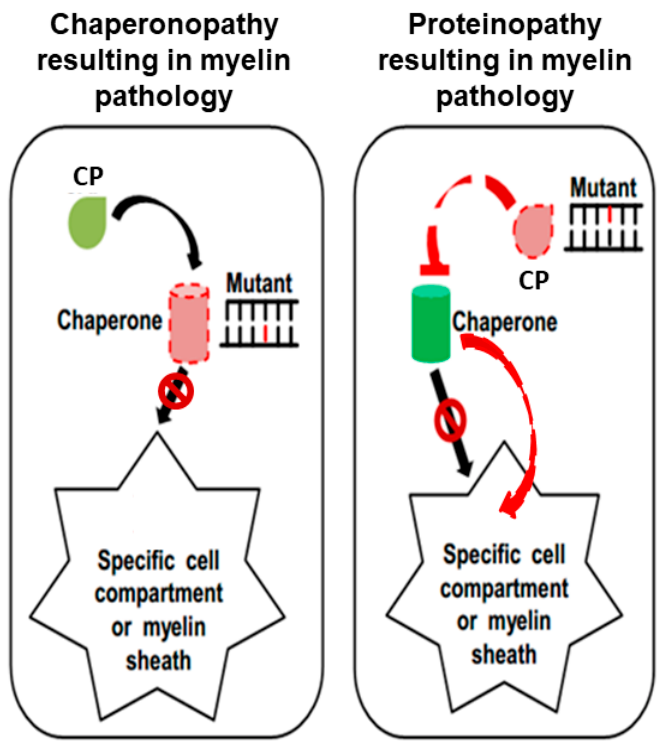
Figure 1. Hypothetical mechanisms involving chaperones in myelination and myelin pathology. Molecular chaperones (normal: green cylinder; abnormal: pink cylinder with dashed-red borders) assist the folding of myelin proteins (drop-shaped icons; normal, light green; abnormal, pink with dashed-red border) in the cell and their migration toward the myelin sheath, and/or directly in situ in the myelin sheath. In order to perform these tasks, chaperones bind their client proteins (substrate;